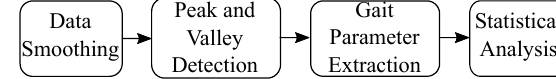
Figure 4. Signal processing procedure for gait